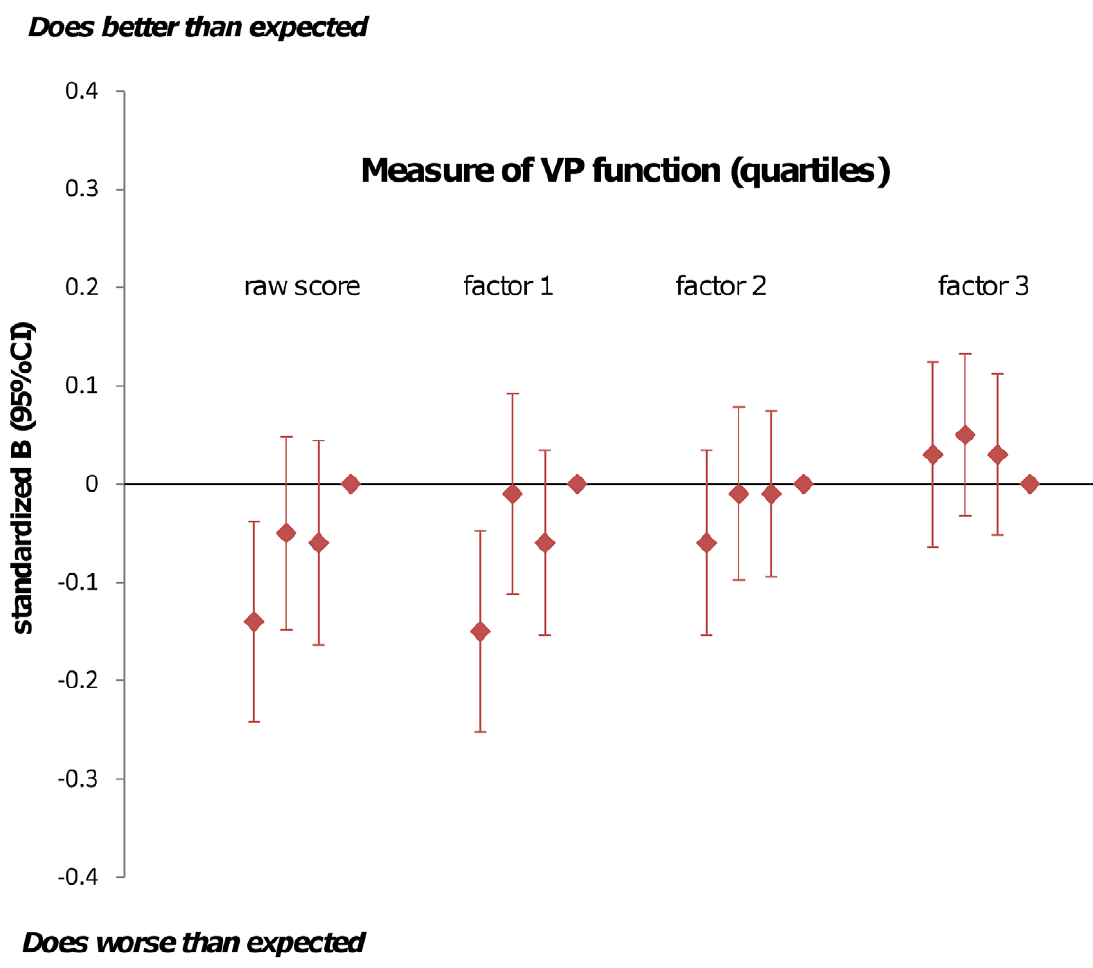
Figure 2. Parameter estimates for measures of visual perception (in quartiles) as predictors of school reading test results. Legend: Analyses adjusted for age at KS3 testing; Gender; Maternal education; Highest maternal/paternal social class; ICD10 diagnosis; visual problems, born at less than 37 weeks gestation; admitted to a Special Care Baby Unit in first month; low birthweight; IQ.